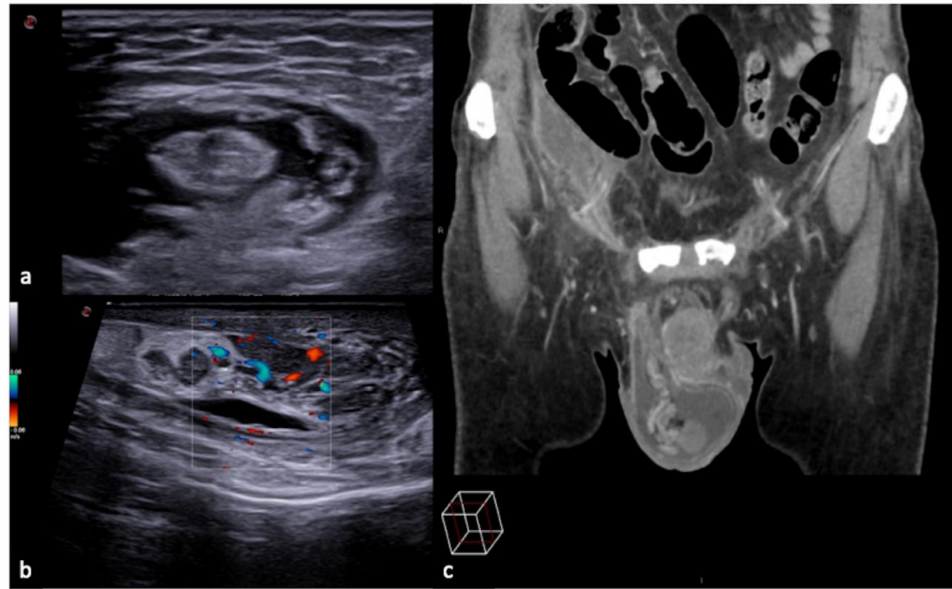
Figure 24. Longitudinal US B-mode ( a ) and color-Doppler ( b ) scan of the inguinal canal show a blockage of the inguinal canal misinterpreted as an inguinal hernia with congested intestinal loop. On CT scan ( c ) it appears to be a right epididymitis with